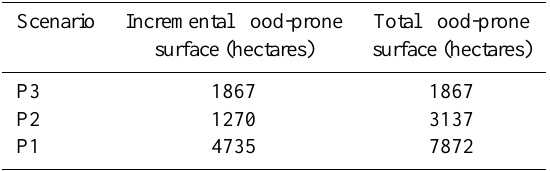
Figure 3. The two typologies of vulnerability along profile lines cited in the text and the corresponding GIS symbol (lower left cor- ner of each schematic). (a) Damage to structures and (b) flooding. For the remaining seven typologies, refer to Ciavola et al. (2008) and Armaroli et al. (2012a). Table 4. Flood-prone surface in terms of incremental surface (addi- tional flood-prone surface of each scenario with respect to the pre- vious one(s)) and total inundated surface.